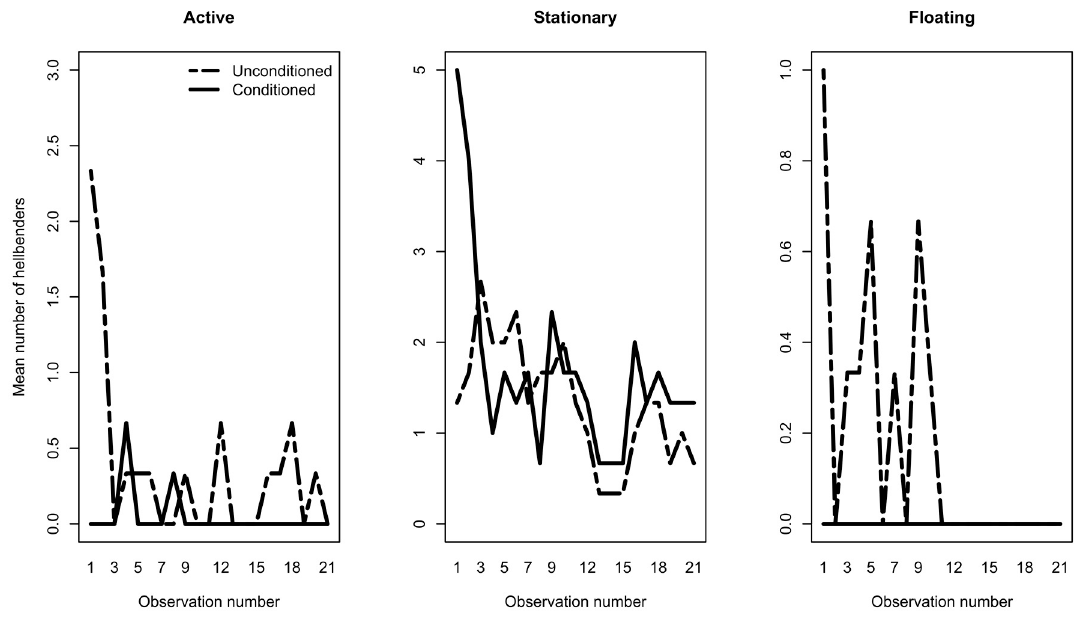
Figure 2. Behavioral observations of unconditioned and conditioned hellbenders in rearing tanks during the 30 d conditioning period. Hellbenders were counted whenever observed outside of tile hides and categorized as active, stationary, or floating. The mean number of hellbenders observed active or floating through time depended on conditioning treatment, such that fewer conditioned individuals were observed active or floating through the duration of the conditioning period compared to unconditioned individuals ( p < 0.05). There were no significant treatment or time effects on stationary behavior.